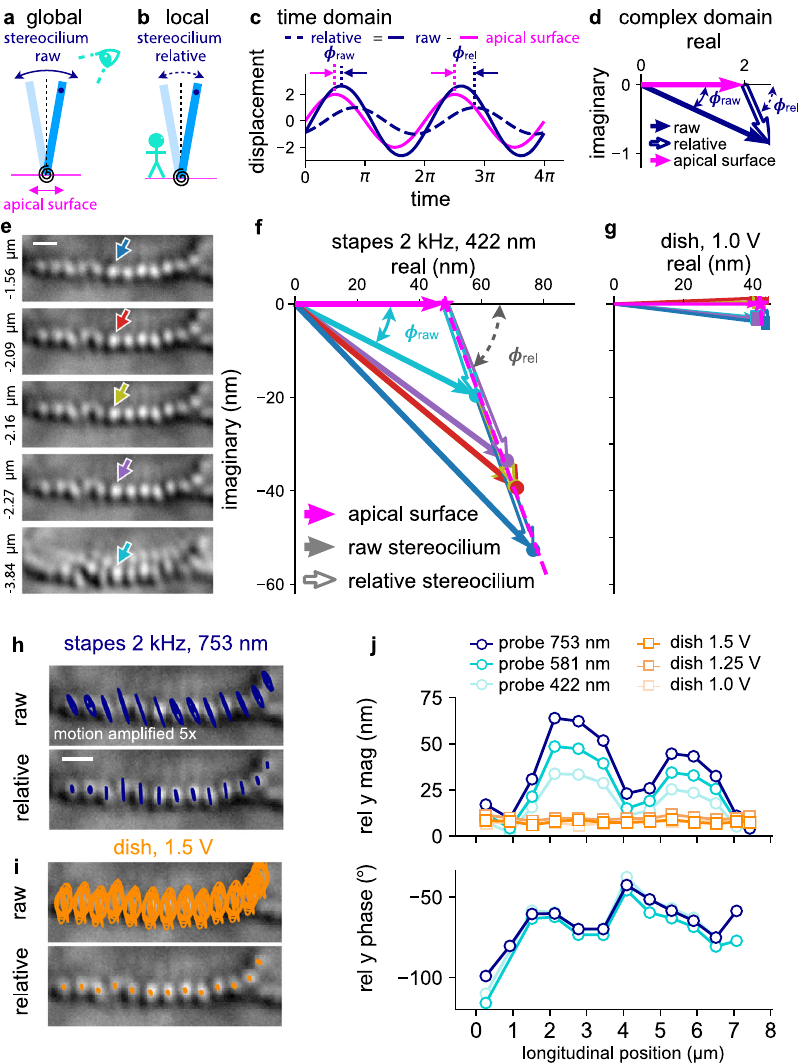
Fig. 2 Calculating relative stereocilium motion. a The raw motion at the top of a stereocilium is the sum of the stereocilium motion relative to the apical surface and the apical-surface motion. b The relative motion of the top of a stereocilium with respect to the apical surface is the difference between the raw motion and the apical-surface motion. c A hypothetical time-domain plot shows the raw motions of a stereocilium and the apical surface, with the relative stereocilium motion obtained by subtracting the apical-surface motion from the raw stereocilium motion. d The time-domain information from c is illustrated in the frequency domain as vectors in the complex plane. The apical-surface motion serves as the zero-phase reference, with the raw stereocilium-motion phase shown as ϕ raw and the relative-motion phase as ϕ rel . e A series of images shows an example bundle at different depths indicated to the left of each image. The 0- μ m depth position is not precisely controlled but is roughly at the top of the stereocilia where the TM is visible and the bundles are blurry. An example stereocilium is singled out using a differently colored arrow at each depth. The scale bar indicates 1 μ m. f , g Complex-amplitude plots of the motions in the radial direction of the example stereocilium in e are shown for a 2-kHz stapes stimulation ( f ) and for dish stimulation ( g ), with the stereocilium-motion vectors color-coded according to the depth in e . The points of the raw stereocilium-motion vectors from different depths are fi tted with a straight line (dashed magenta; R 2 = 0.97), whose intersection with the real axis indicates the calculated apical-surface- motion vector. The relative-motion vectors are shown as hollow arrows. h , i For the example bundle of e – g , the trajectories of the raw (upper) and relative (lower) stereocilium motion (scaled up 5×) are superimposed on top of the original image for stapes stimulation ( h ) and 2-kHz dish stimulation ( i ), with a 1- µ m scale bar. j The radial-direction relative-motion magnitudes (upper) and phases (lower) relative to the apical surface for each stereocilium are plotted against the longitudinal position of the stereocilium. The relative-motion phases for dish stimulation are omitted from the plot because the phase calculations are error-prone for close-to-zero straight line indicates that the relative phase ( ϕ rel ) of the stereocilium is constant along its length. According to mechanics theory, this constant phase implies that there was little viscous loss along the stereocilium shaft, consistent with the hypothesis that the stereocilium pivots as a rigid rod. For dish stimulation (Fig. 2g), the raw-motion vectors of the example stereocilium are roughly the same at different depths and body all move together. This expected result together with the